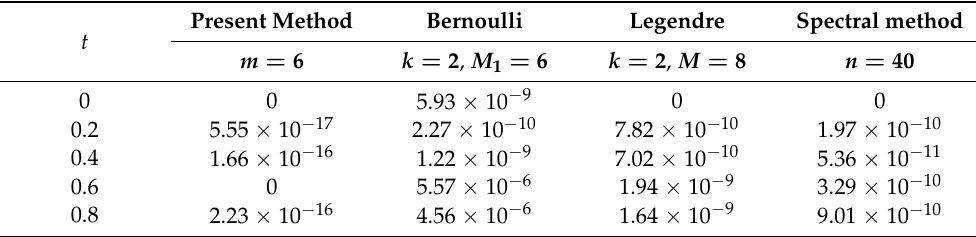
Table 8. The results for the absolute errors of the approximate solutions provided by the present method and the methods of